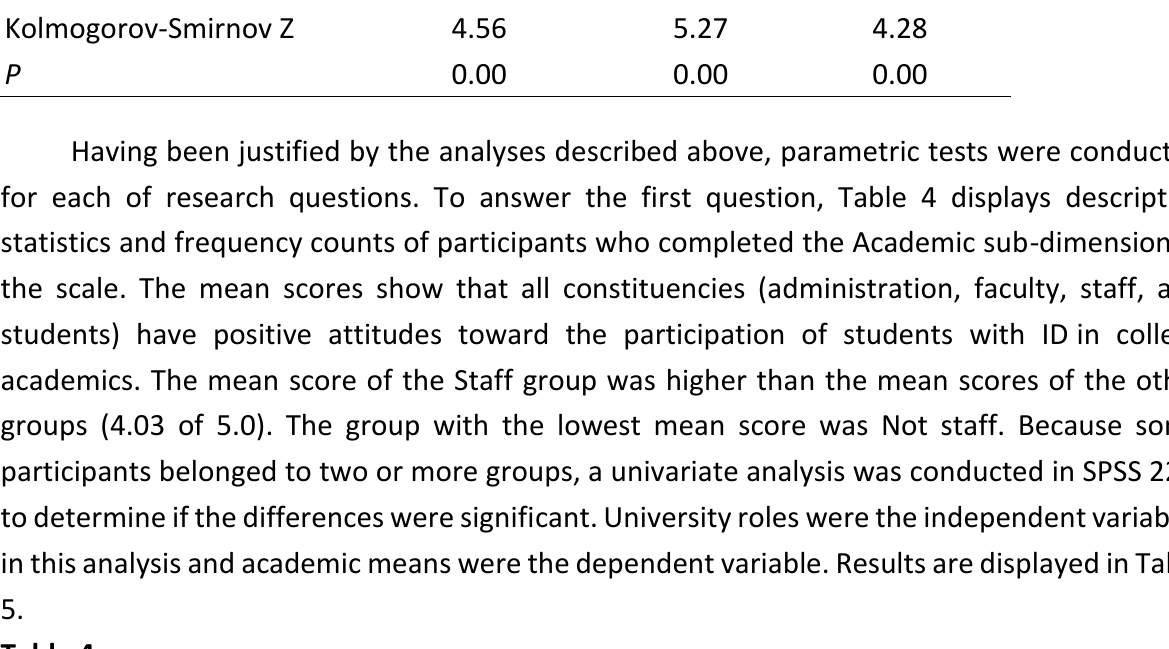
The Descriptive Statistics and Frequencies of Each